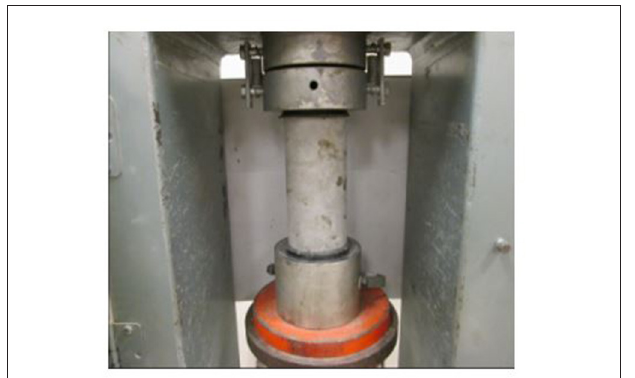
FIGURE 6 | Unlined (control) cylinder prior to compression testing.